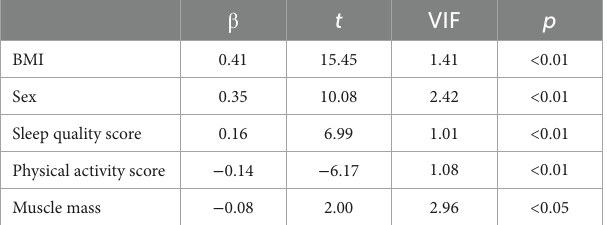
TABLE 3 Factors that contributed to body dissatisfaction of university